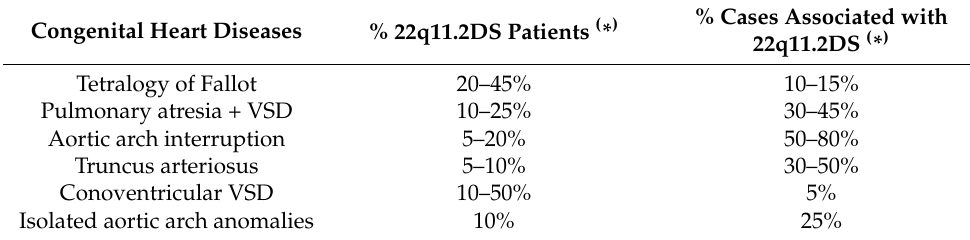
Table 1. Prevalence of the most frequent congenital heart diseases observed in 22q11.2DS. Congenital Heart